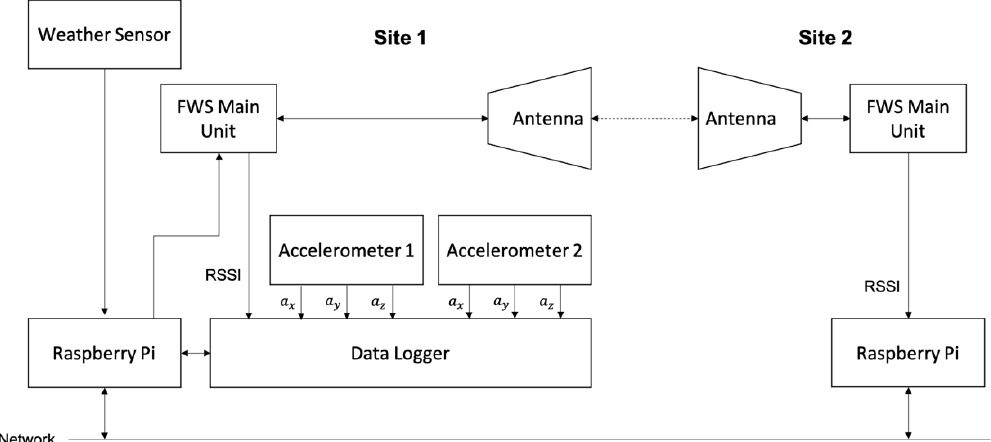
Figure 2. The map of experimental locations with their GPS coordinates.